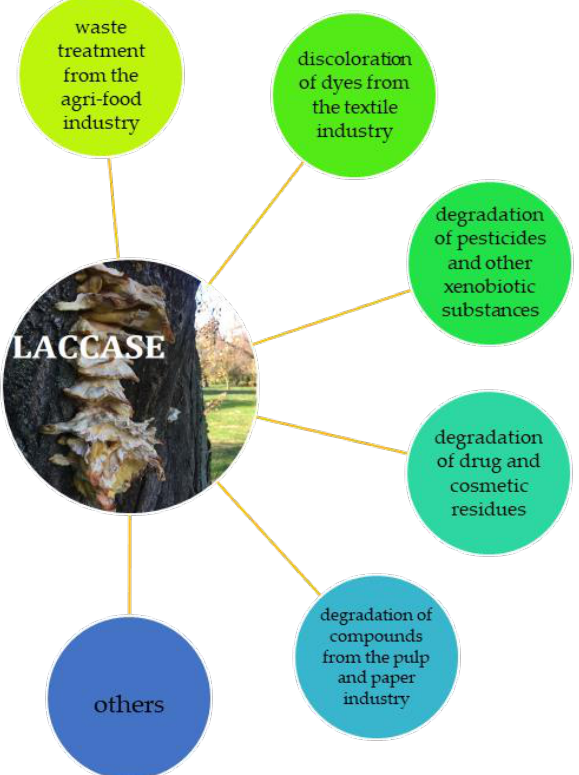
Figure 1. The use of laccases for the degradation of waste and hazardous compounds (authors creation).